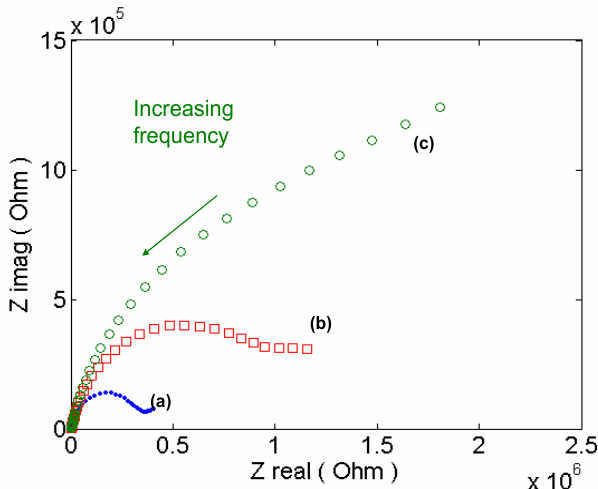
Figure 8. Electrochemical impedance spectra response recorded at: (a) the gold electrode, (b) the biotinylated anti-human C-terminal telopeptide antibody modified electrode, (c) C-terminal telopeptide immobilization. EIS was done at a DC potential of 0.2 V at frequencies between 0.1 Hz and 300 KHz. The sinusoidal potential magnitude was 20 mV Fe(CN) and 5.0 mM of K Fe(CN) in PBS (pH in 5.0 mM K 3 6 4 6